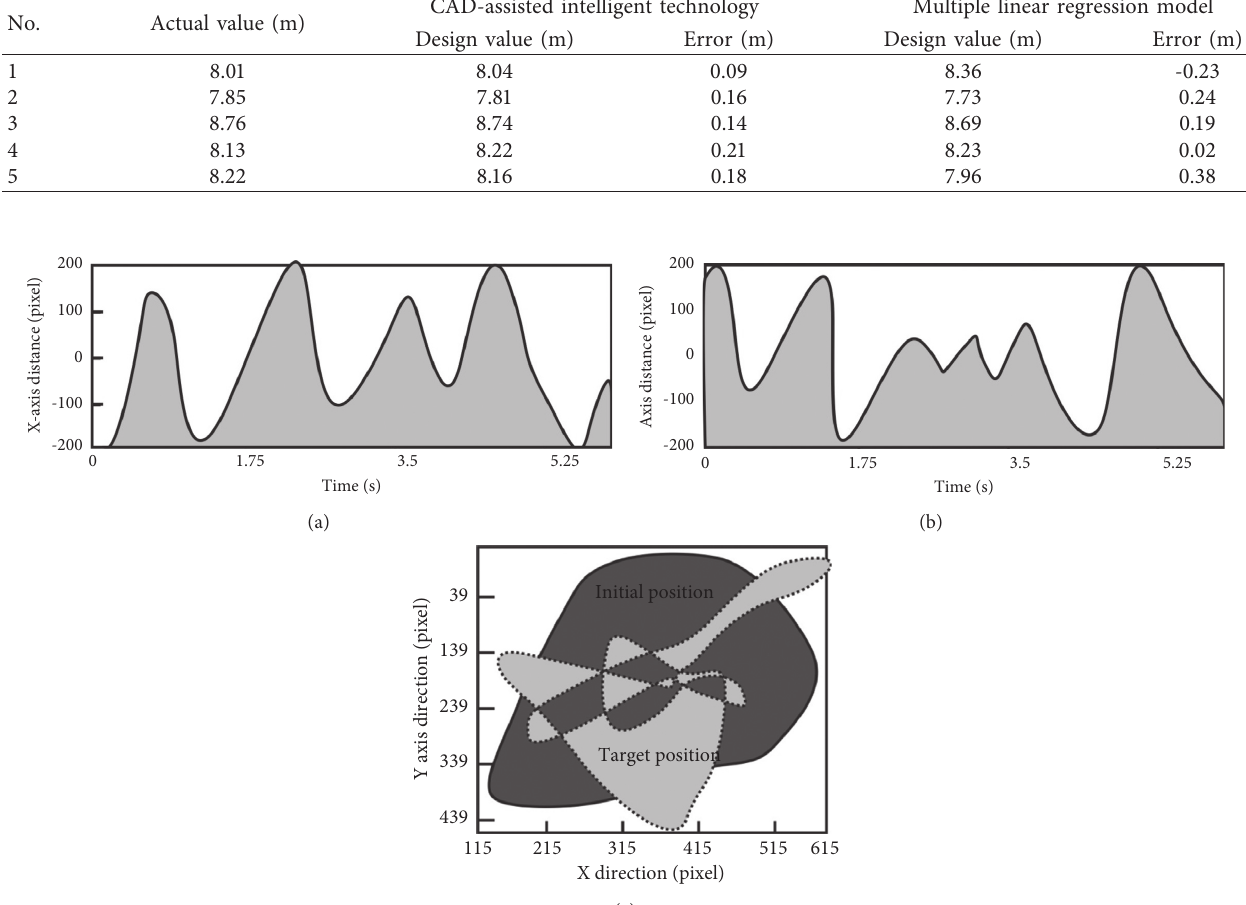
Table 3: Preparation and accuracy of the design model.